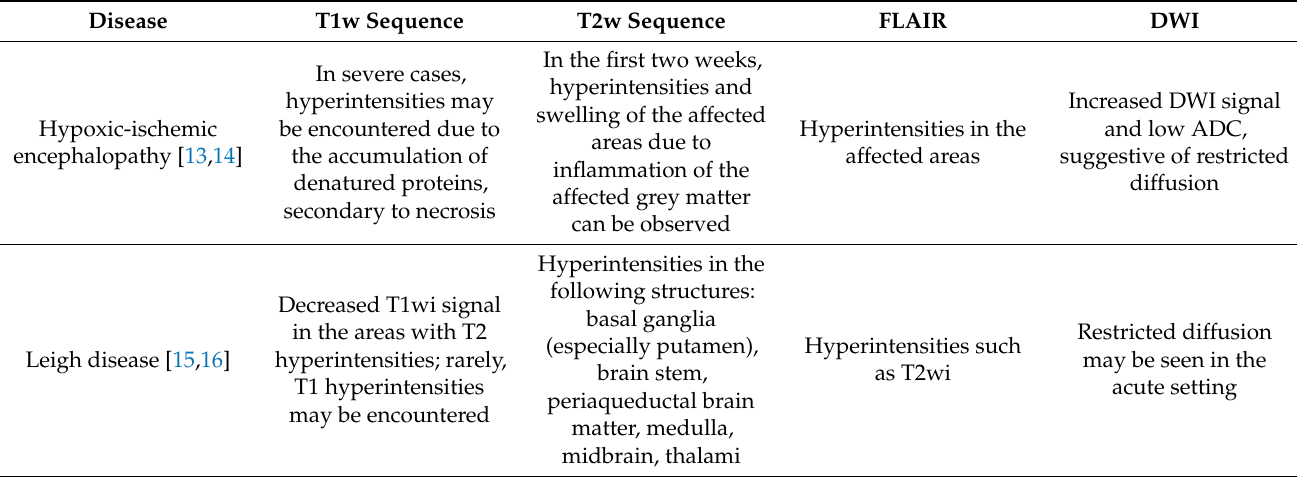
Table 1. MRI abnormalities of the basal ganglia found in different pathologies.